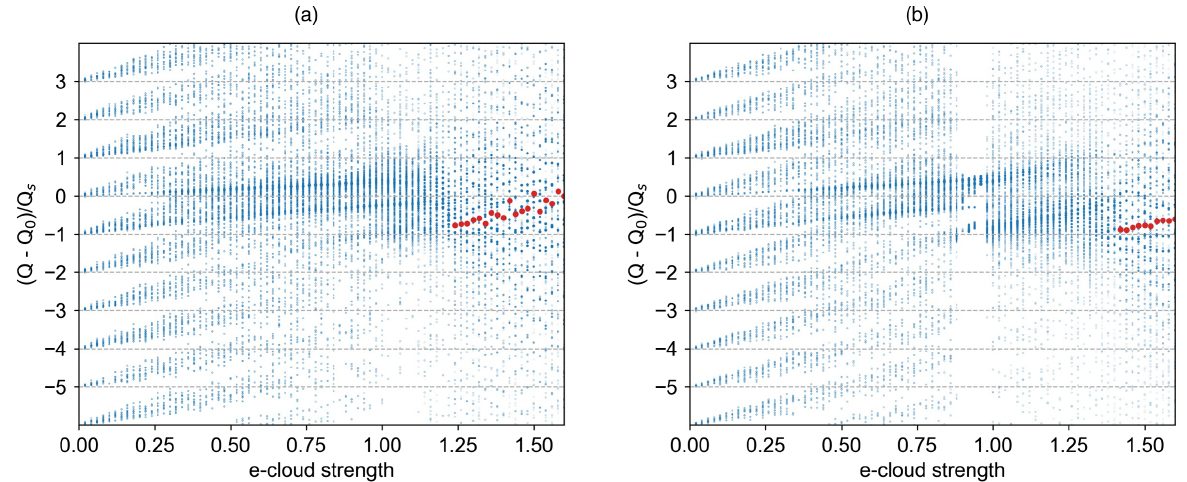
FIG. 10. (a) Spectrum of the transverse motion obtained from P y HEADTAIL macroparticle simulations performed with the PIC method. (b) Spectrum of the transverse motion obtained from macroparticle simulations performed with the linearized model and a static non- linear map to model the e-cloud transverse nonlinearities. In the range in which the instability is very fast, the strongest spectral component is highlighted in